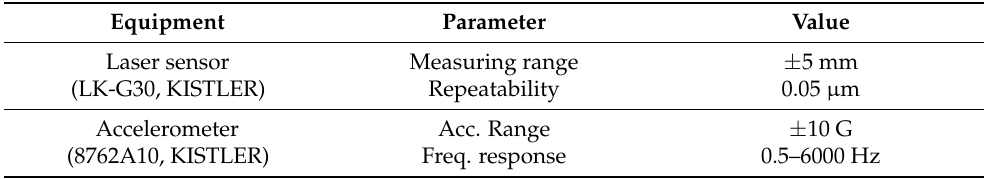
Table 1. Components of the experimental